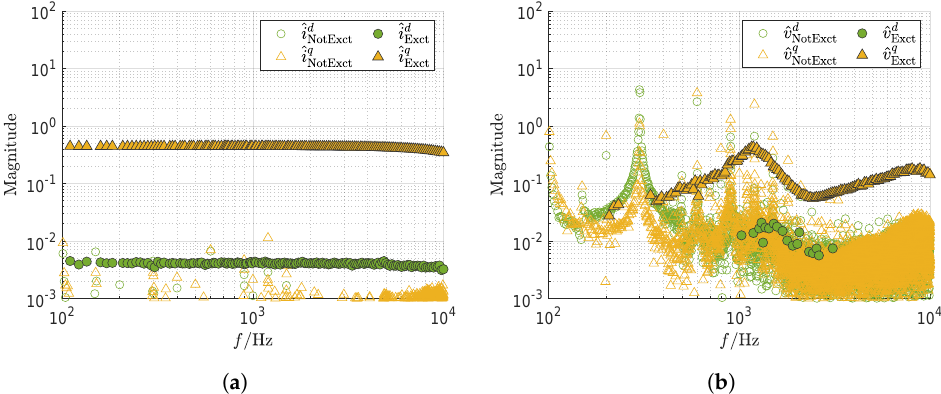
Figure 27. Compensated measurement of the industrial power grid during excitation of the q -axis. ( a ) Spectrum of the current i meas in the dq domain. ( b ) Spectrum of the voltage v meas in the dq